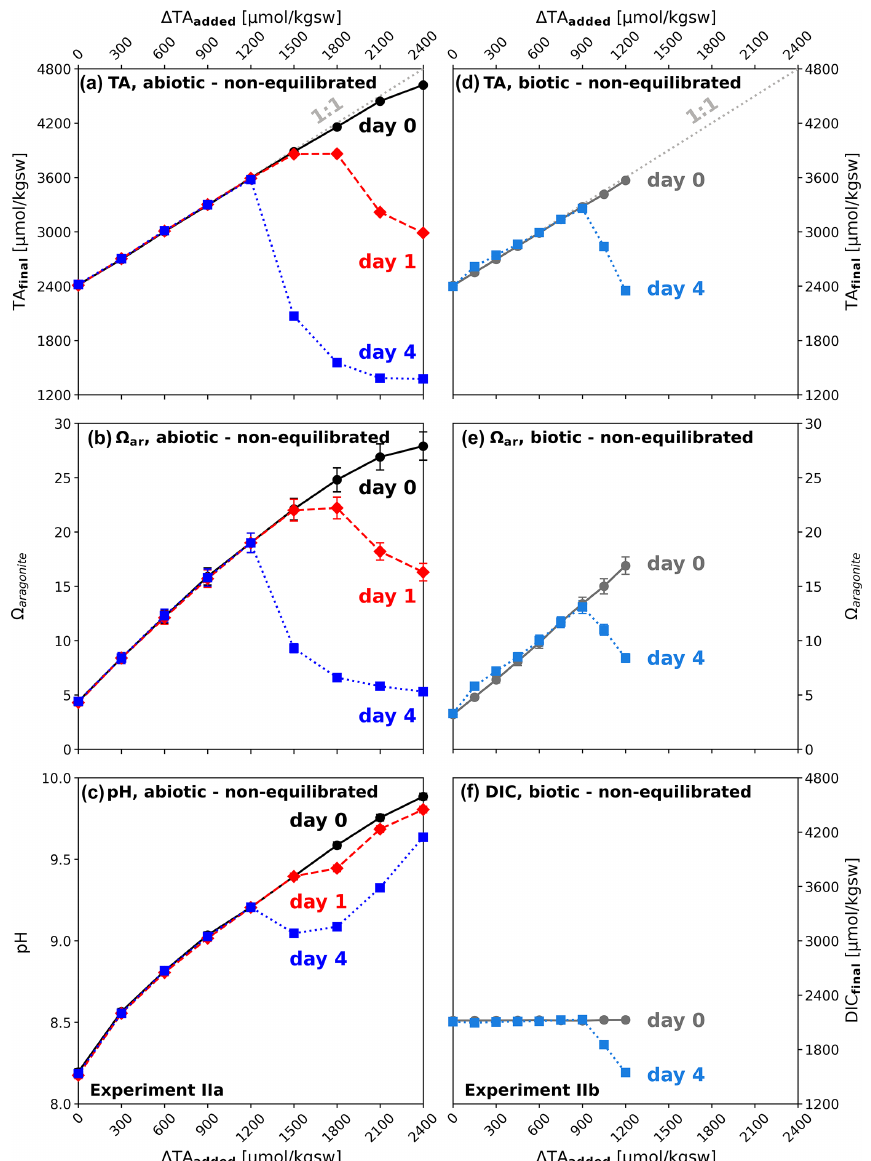
Figure 2. Temporal development after non-equilibrated alkalinization: (a, b, c) experiment IIa, (d, e, f) experiment IIb; (a, d) (cid:49) TA added vs. TA final ; (b, e) aragonite saturation state ( (cid:127) aragonite ) in relation to (cid:49) TA added ; (c) pH in relation to (cid:49) TA added ; (f) DIC final in relation to (cid:49) TA added . Black/grey symbols correspond to the start of the experiment, red after 1d, and blue after 4d. Note the different ranges of (cid:49) TA added in the abiotic and biotic set-up. The slightly higher start (cid:127) aragonite for the biotic treatment at day 4 compared to day 1 is because (cid:127) aragonite was calculated by using TA and DIC, while for the abiotic experiment using TA and